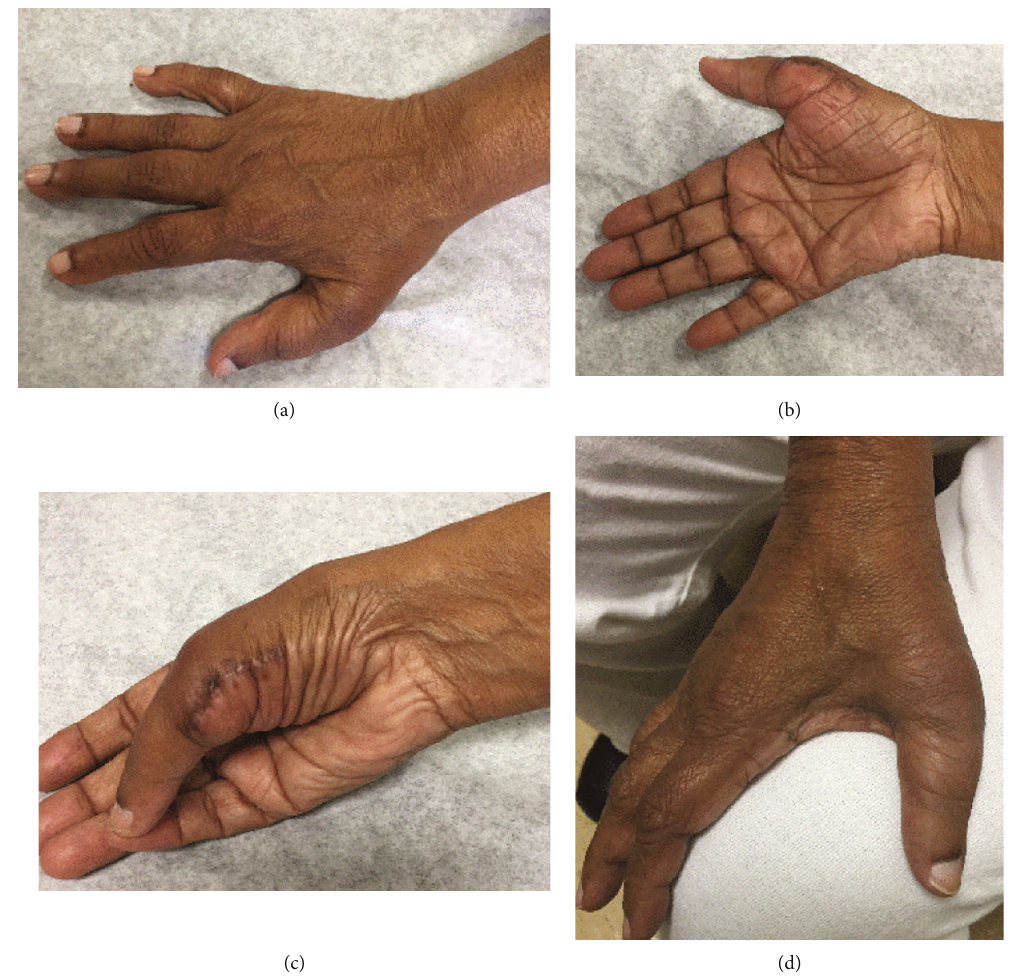
Figure 5: Seven-week postoperative clinical photos demonstrating an attractive cosmetic result. (a) No visible scar dorsally. (b) Minimal visible scar over the volar radial aspect of the right thumb. (c) Full opposition of the right thumb to the distal fi fth phalanx. (d) Twelve- week postoperative visit with minimal scar formation and satisfactory thumb